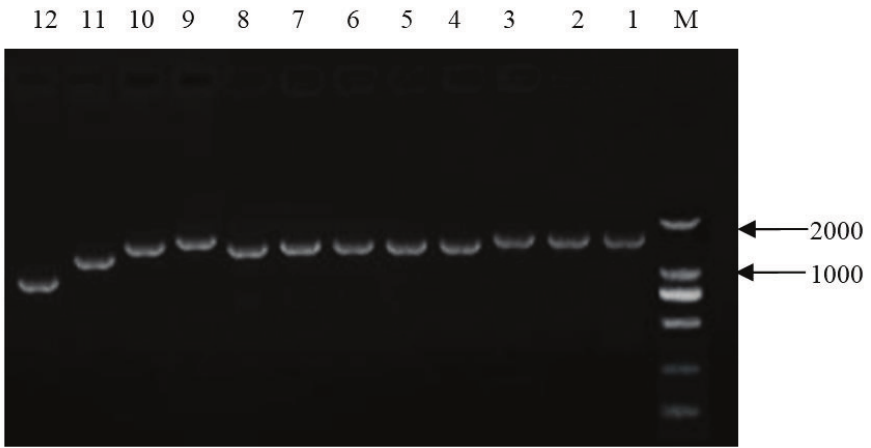
Figure 1. PCR amplification on the complete gene of HB-XL strain M, DL2000Maker; 1 – 12, complete gene of the HB-XL strain.